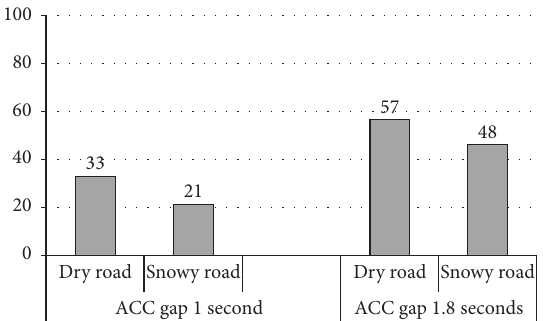
Figure 2: Acceptance ratings of the ACC gaps in different road conditions. Data is presented in